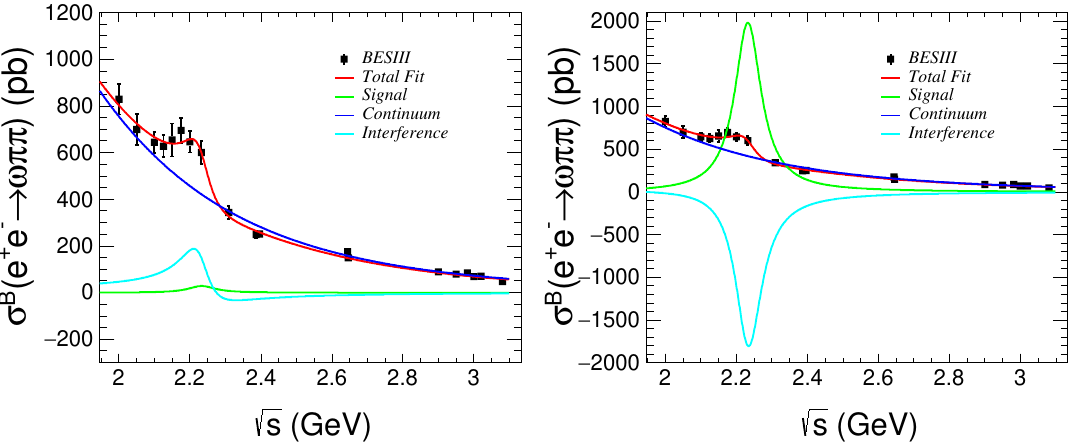
Figure 9 . Fits to the cross sections of e + e − → ωππ . The dots with error bars are the results combined from this work and ref. [52], where the error bars include both statistical and systematic uncertainties. The red solid curves are the total fit results, the blue solid curves represent the continuum components, the green curves denote the resonant components, and the cyan line are the interference of the two components. The two plots are the results of Solutions I (left) and II (right),